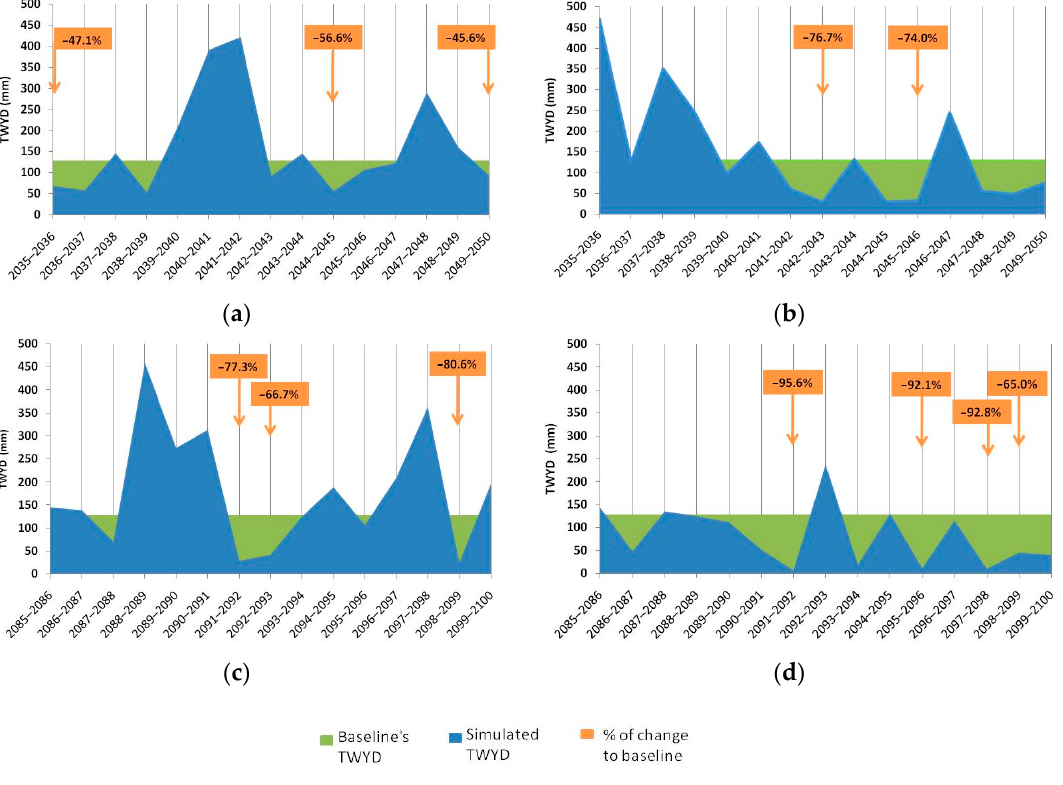
Figure 12. Simulated annual TWYD under ( a ) RCP4.5 and ( b ) RCP8.5 for the period 2035–2050, and under ( c ) RCP4.5 and ( d ) under RCP8.5 for the period 2085–2100 compared to baseline TWYD average along with TWYD decrease during the future dry years.